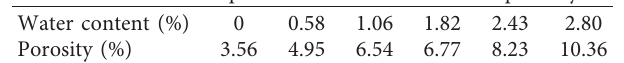
Figure 8: Binary images. (a) ω � 0%. (b) ω � 0.57%. (c) ω � 1.06%. (d) ω � 1.82%. (e) ω � 2.43. (f) ω � 2.80%. Table 4: Relationship between water content and